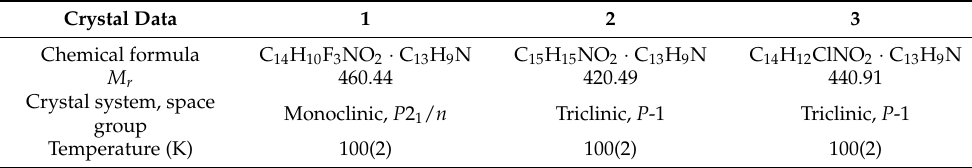
Table 1. Crystallographic data and refinement parameters for fenamic acids–acridine complexes. Crystal